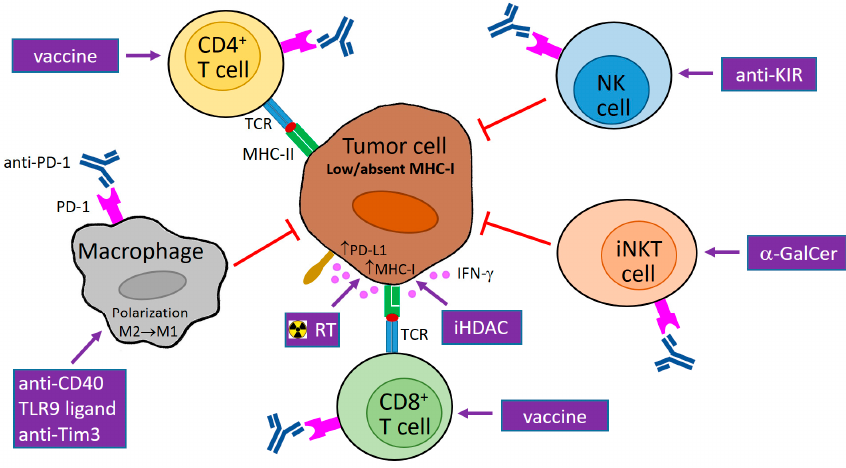
Figure 1. Potential usage of programmed cell death protein 1 (PD-1) blockade in combination therapy of tumors with downregulated major histocompatibility class I (MHC-I) expression. MHC-I expression in tumor cells can be reduced reversibly by epigenetic regulations or irreversibly by genetic aberrations. Abrogated interferon (IFN)- γ signaling can contribute to low MHC-I expression. The blockade of PD-1 molecules on natural killer (NK), invariant NKT (iNKT), and cluster of differentiation 4 + (CD4 + ) T cells supports the direct cytotoxicity of these cells to tumor cells that is not restricted by MHC-I molecules (and is dependent on MHC-II expression in the case of CD4 + T cells). In tumor cells with reversible MHC-I downregulation and functional IFN- γ signaling, MHC-I molecules are upregulated by IFN- γ produced by activated immune cells, e.g., iNKT cells, NK cells, and T lymphocytes stimulated by α -galactosylceramide ( α -GalCer), antibody against a killer-cell immunoglobulin-like receptor (KIR), and a vaccine, respectively. As this enhancement of MHC-I expression is accompanied by PD-1 ligand 1 (PD-L1) upregulation, a PD-1/PD-L1 blockade is needed for the restoration of anti-tumor activity of cytotoxic CD8 + T cells, which can be augmented by tumor-specific vaccination. MHC-I expression in tumor cells is further inducible by radiotherapy (RT) and inhibitors of histone deacetylases (iHDAC). Anti-PD-1 therapy also stimulates the secretion of T helper type 1 (Th1) cytokines (including IFN- γ ) and chemokines by immune cells, and could induce the polarization of tumor macrophages to